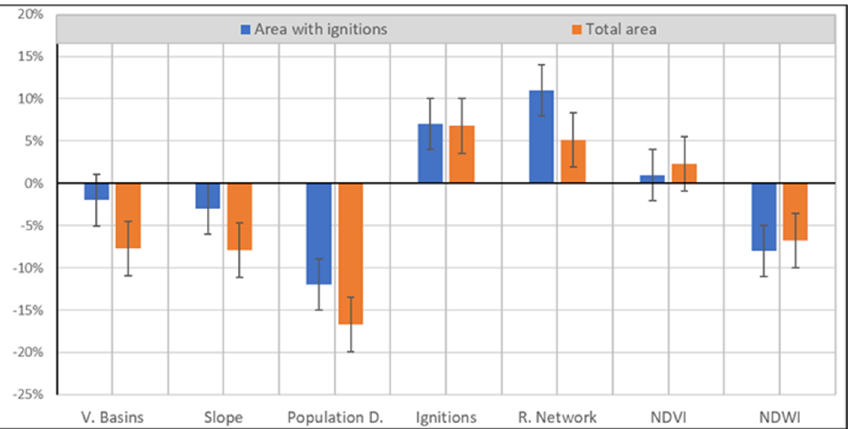
Figure 8. The area variance of the individual variable removal when compared with the MDIR model.